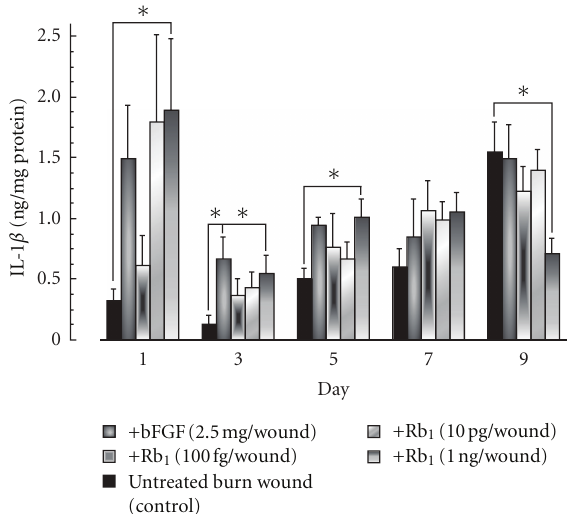
Figure 3: E ff ects of ginsenoside Rb 1 and bFGF on IL-1 β production in the exudates of burns in male Balb/c mice [26]. The burn wounds were created on the backs of male Balb/c mice (6 weeks old) under anesthesia with pentobarbital. A polyethylene filter pellet (about 8 in mm diameter, 3mm thick) containing the indicated amount of basic fibroblast growth factor (bFGF) or ginsenoside Rb 1 was applied to the burn wounds surface. On days 1, 3, 5, 7, and 9, the filter pellets were removed and replaced with fresh filter pellets. For control mice, filter pellets containing saline alone were applied according to the same schedule. Immediately after removal, phosphate-bu ff ered saline (PBS, pH 7.0) (200 μ l) was added to each filter pellet and mixed for 10min. The IL-1 β levels in the filter pellets were measured using a mouse IL-1 β ELISA kit. Values are the mean ± SE for 6 mice. ∗ Significantly di ff erent from control, P < 0 . 05.